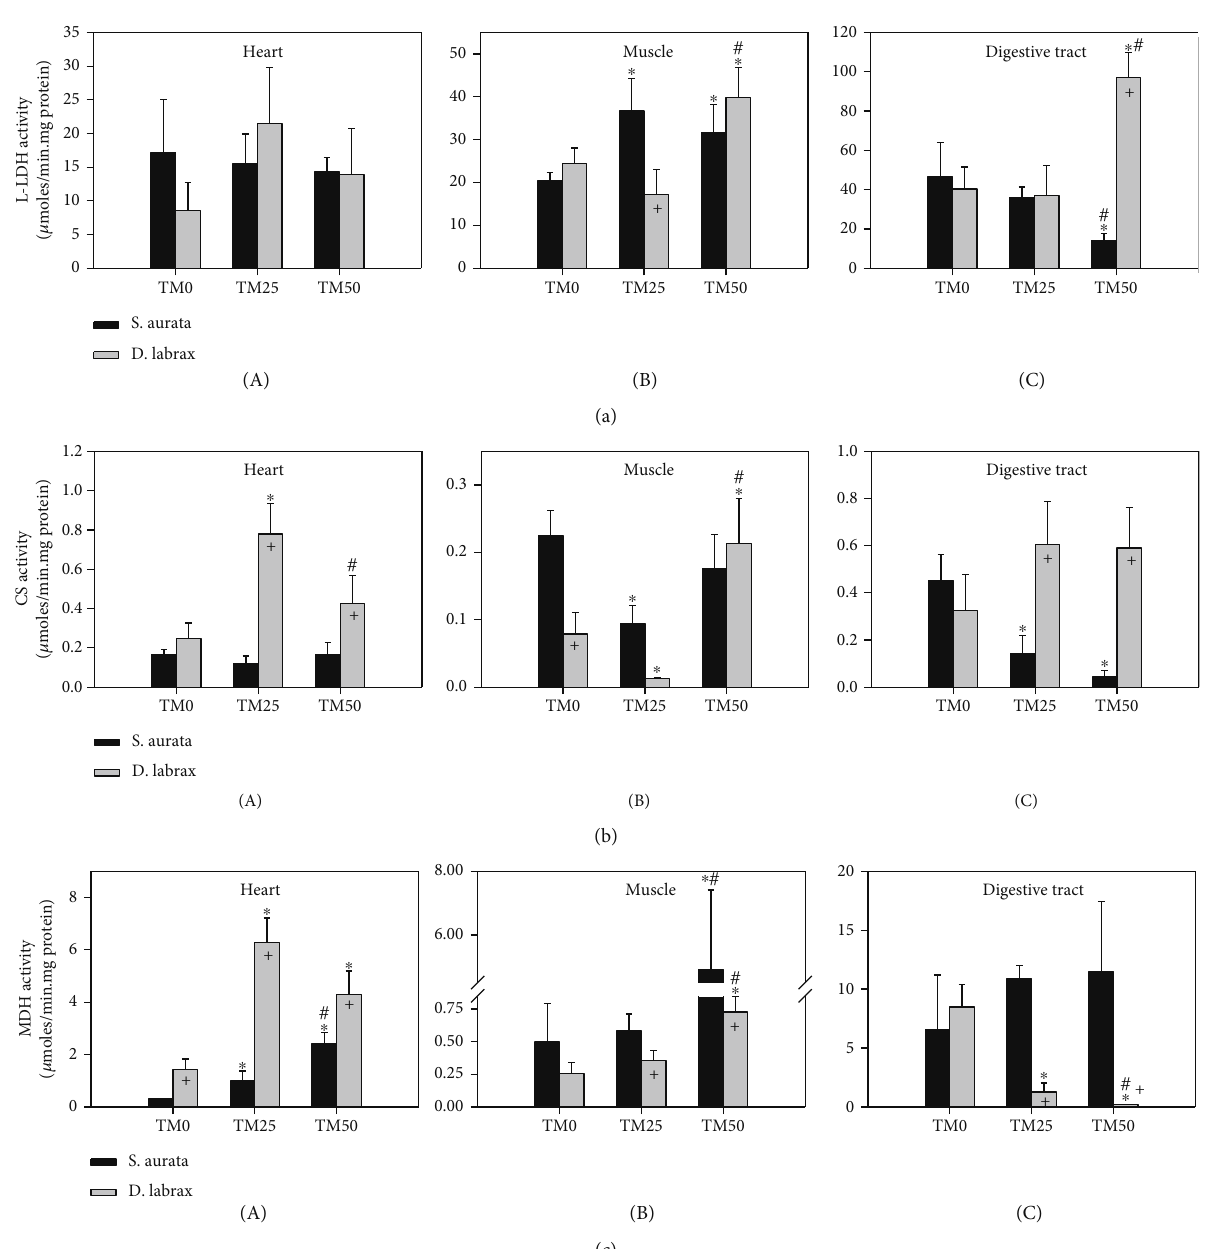
Figure 7: Activities of lactate dehydrogenase (L-LDH) (a), citrate synthetase (CS) (b), and malate dehydrogenase (MDH) (c) in the heart (A), muscle (B), and digestive tract (C) of gilthead sea bream ( S. aurata ) and European sea bass ( D. labrax ) under the 0% (TM0), 25% (TM25), and 50% (TM50) T. molitor inclusion diet treatment. Values represent means ± SD ; n = 5 preparations from di ff erent animals. ∗ indicates p < 0 : 05 compared with 0%, # indicates p < 0 : 05 compared with 25%, and + indicates p < 0 : 05 between species at the same TM